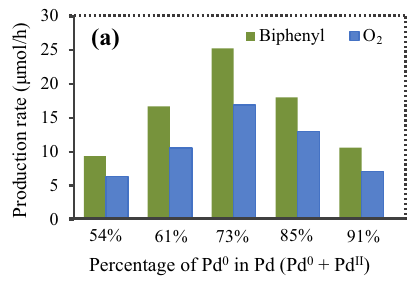
(green) or Pd/g-C 3 N 4 * (blue). For experimental procedures, see Unit 1.6 and 1.7 in the supplementary information. Source data are provided as a Source Data fi le.